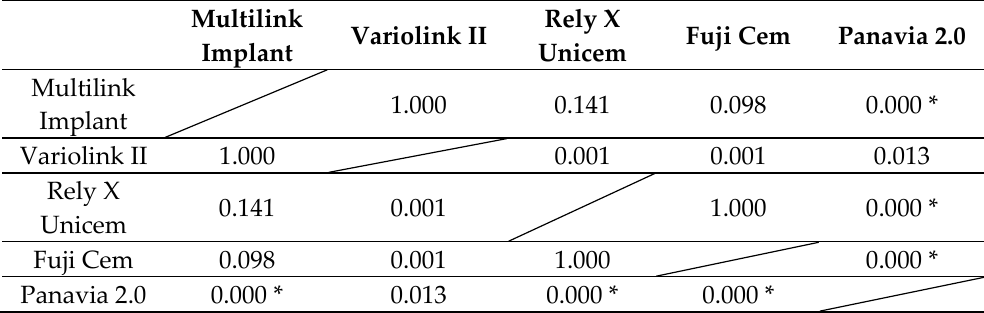
Table A4. Comparison of the different adhesives during the pull-off test: Vita Enamic.